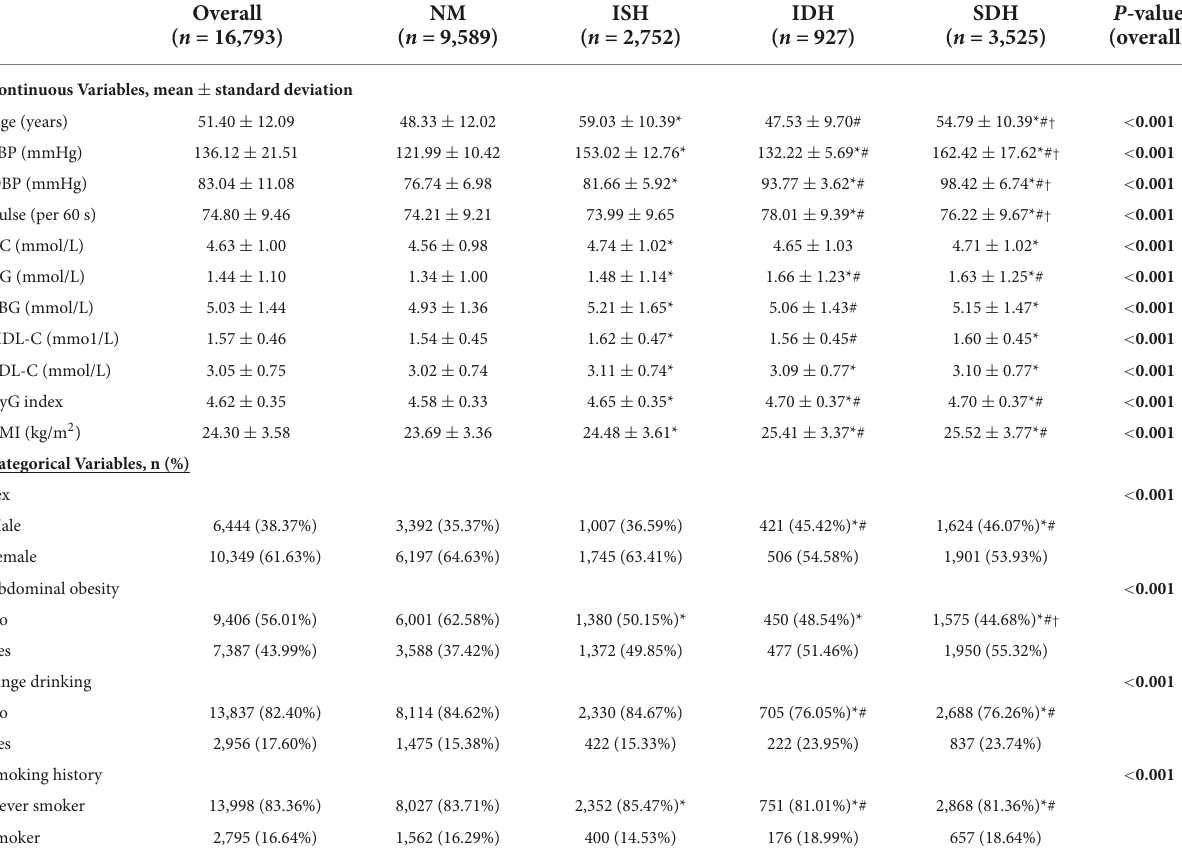
TABLE 1 Sociodemographics, lifestyles and clinical characteristics, overall and by hypertension subtypes, Shandong, China (2007–2010).